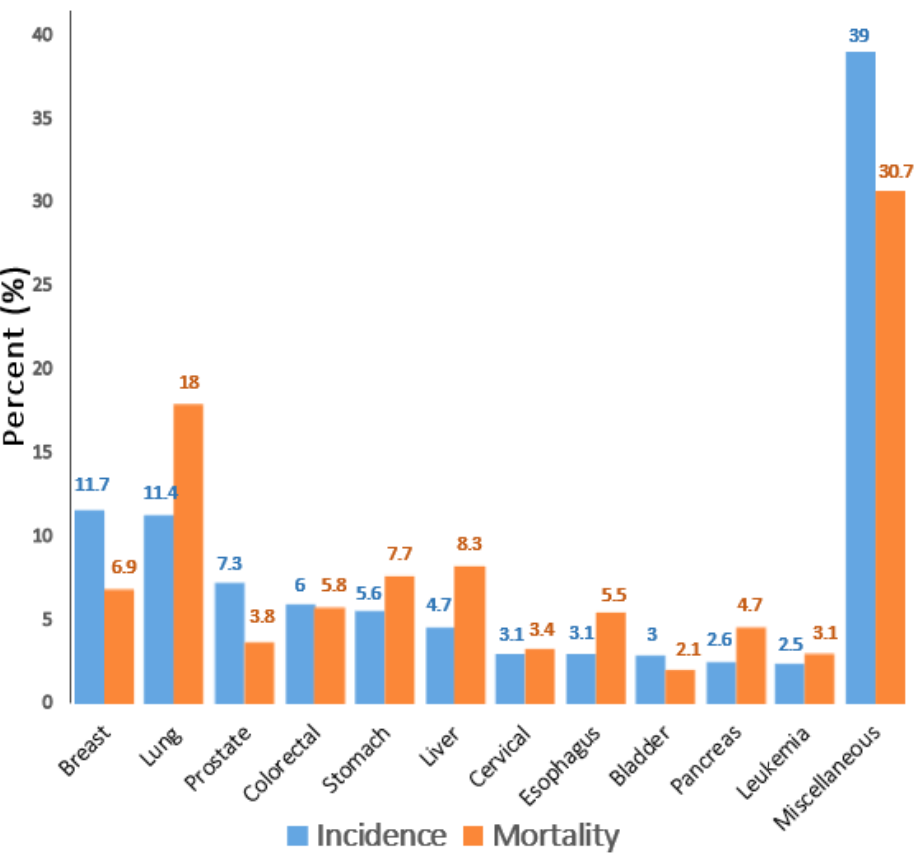
Figure 1. Incidence and mortality rates of different cancer types in 2020. Percent increases in incidence and mortality rates of different cancers are shown, with breast, lung, prostate, colorectal, and stomach cancers having the highest incidence and mortality rates. Cancers with low percent incidence and mortality rates are combined as miscellaneous cancers.